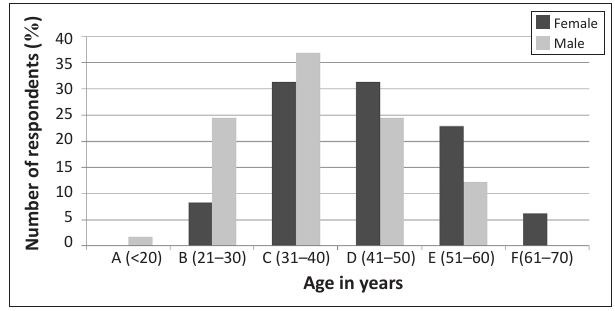
FIGURE 2: Age distribution of male and female respondents.